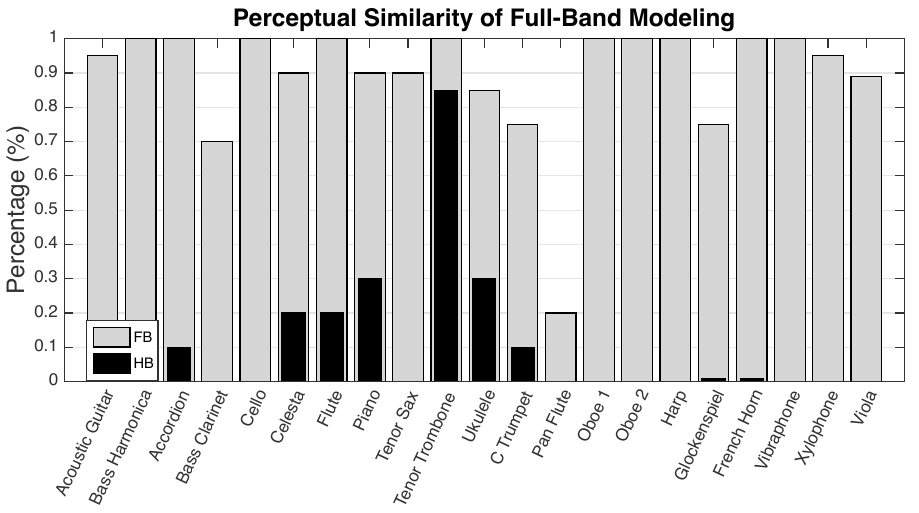
Figure 7. Result of the listening test on perceptual similarity of full-band (FB) and half-band (HB) resynthesis with eaQHM compared to the original recording. The sounds used in the listening test appear in bold in Table